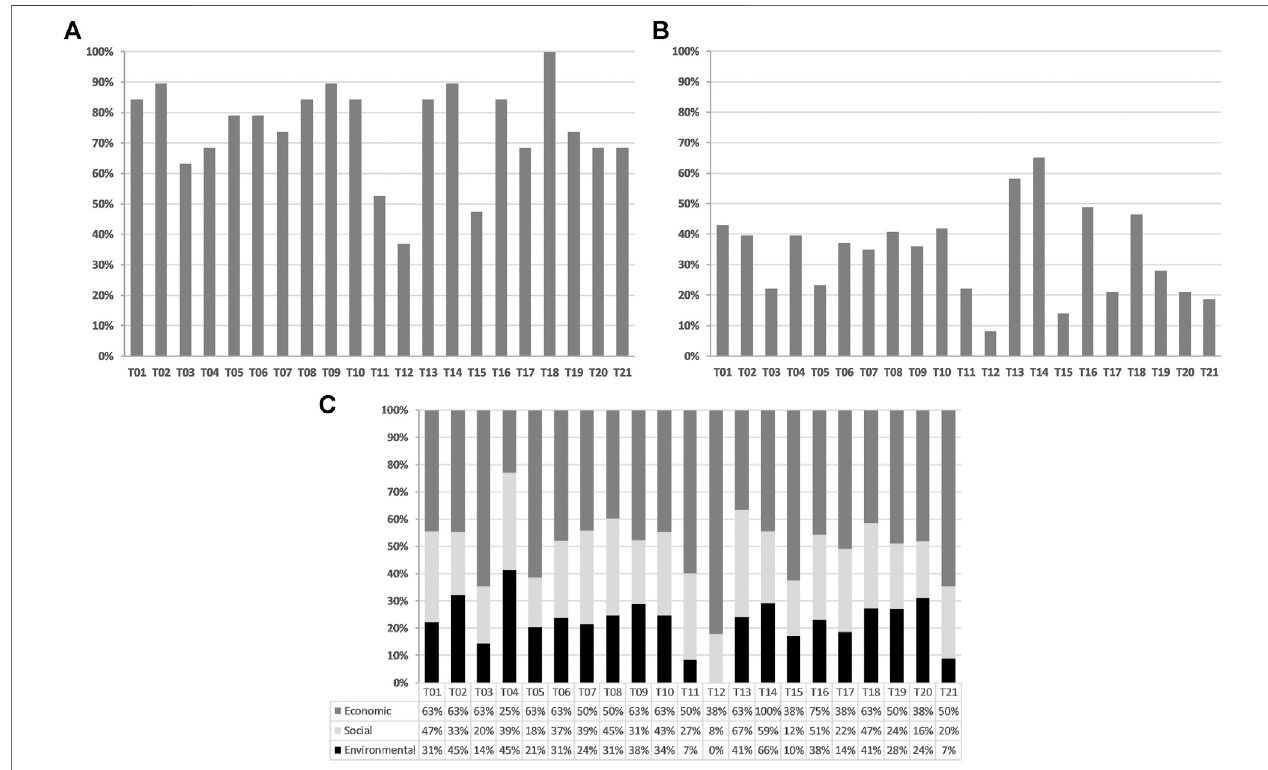
FIGURE3| Coverageanalysis:coverageofdomainsandsubdomainsinexaminedtools. (A) PercentageofdomainsincludedineachtoolrelativetoCLCdomains, (B) percentage of subdomains included in each tool relative to CLC subdomains, (C) percentage of subdomains included in each core dimension of QOL (bar height is normalized for ease of